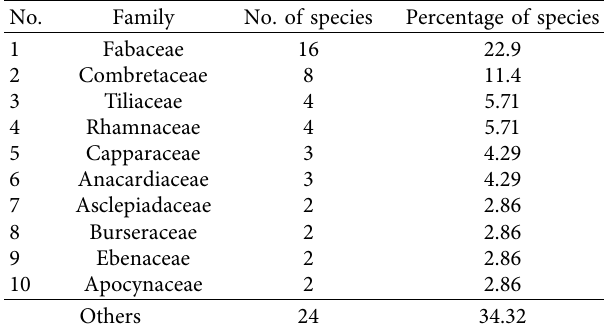
Table 3: Dominant families encountered in Kafta Sheraro National Park